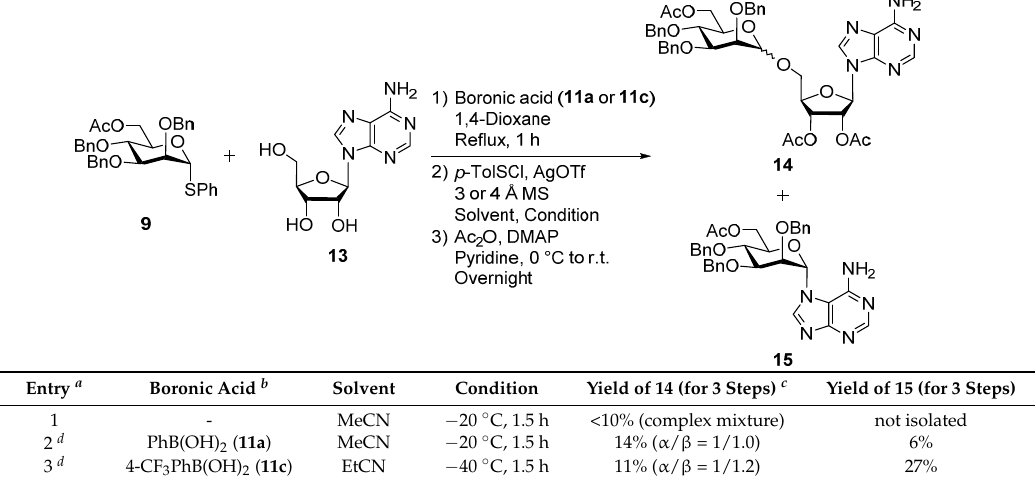
Table 2. O -glycosylation of adenosine 13 with thiomannoside 9 in the absence and presence of boronic acid.